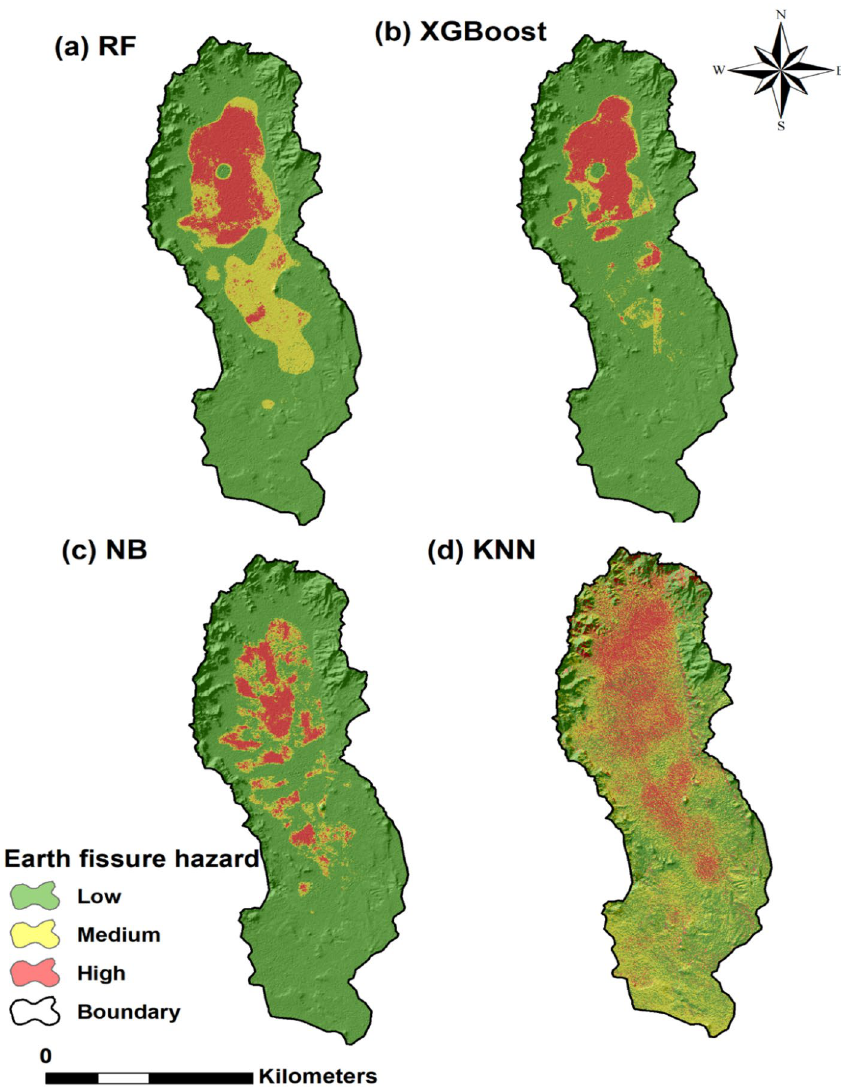
Figure 7. Maps of earth fissure hazard by the ( a ) RF, ( b ) XGBoost, ( c ) NB, and ( d ) KNN models (Developed by the first author using ArcGIS (v. 10.3), https:// suppo rt. esri.